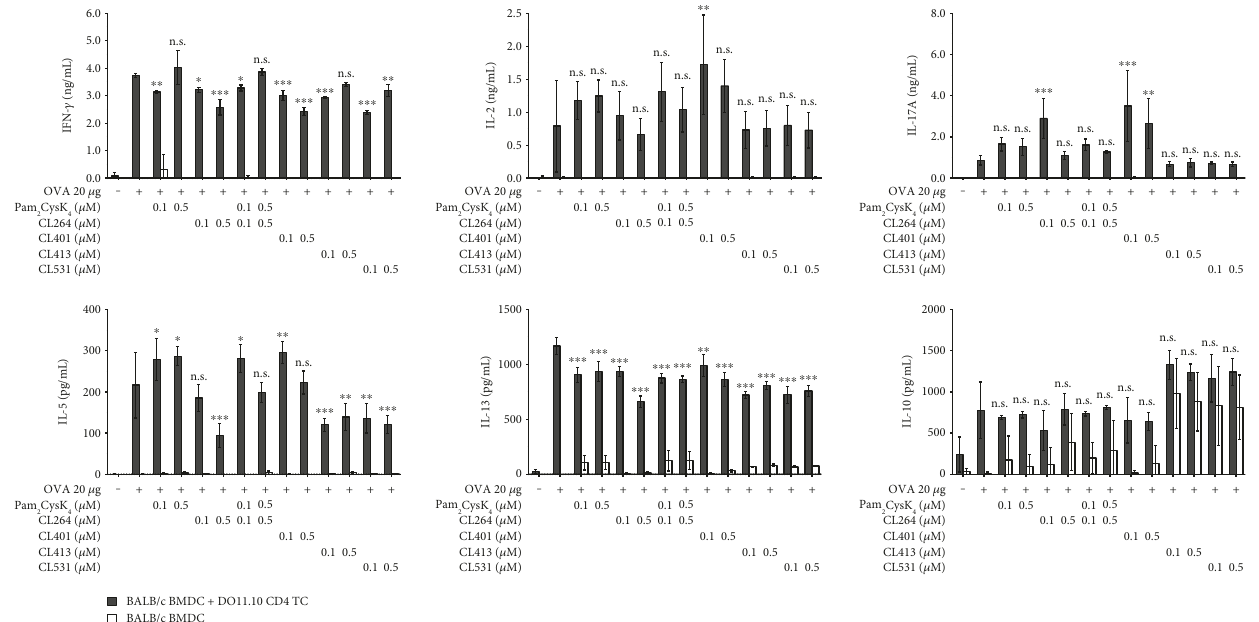
Figure 2: The dual TLR2/7 ligands CL413 and CL531 suppress rOVA-induced Th2 cytokine secretion while CL401 induces IL-17A secretion. Cytokine secretion from stimulated BALB/c BMmDC:DO11.10 CD4 + TC cocultures. Data are mean results of two independent experiments ± SD. n.s. / ∗ / ∗∗ / ∗∗∗ : statistical signi fi cance compared to the OVA 20 μ g